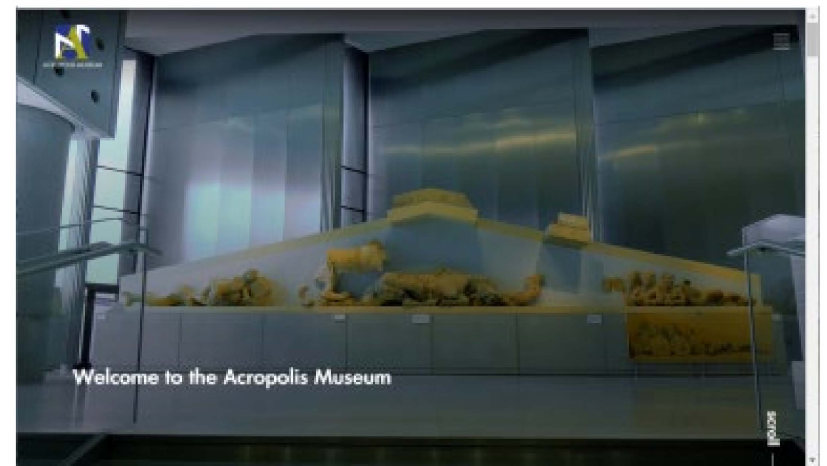
Figure 5. The website of the Acropolis museum today.